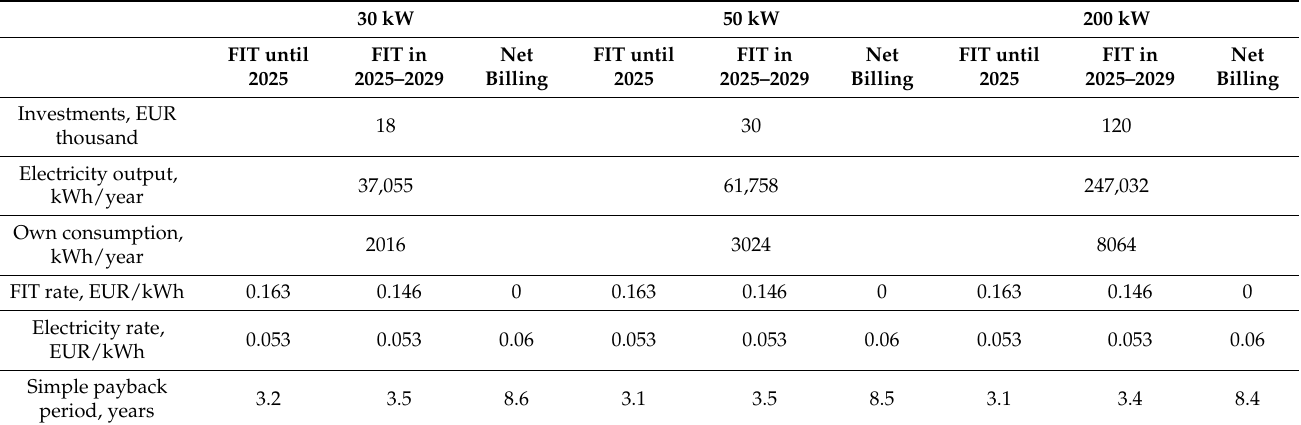
Table 3. The simple payback period for a 50 kW solar PV installation with FIT or net billing in Ukraine. 30 kW 50 kW 200